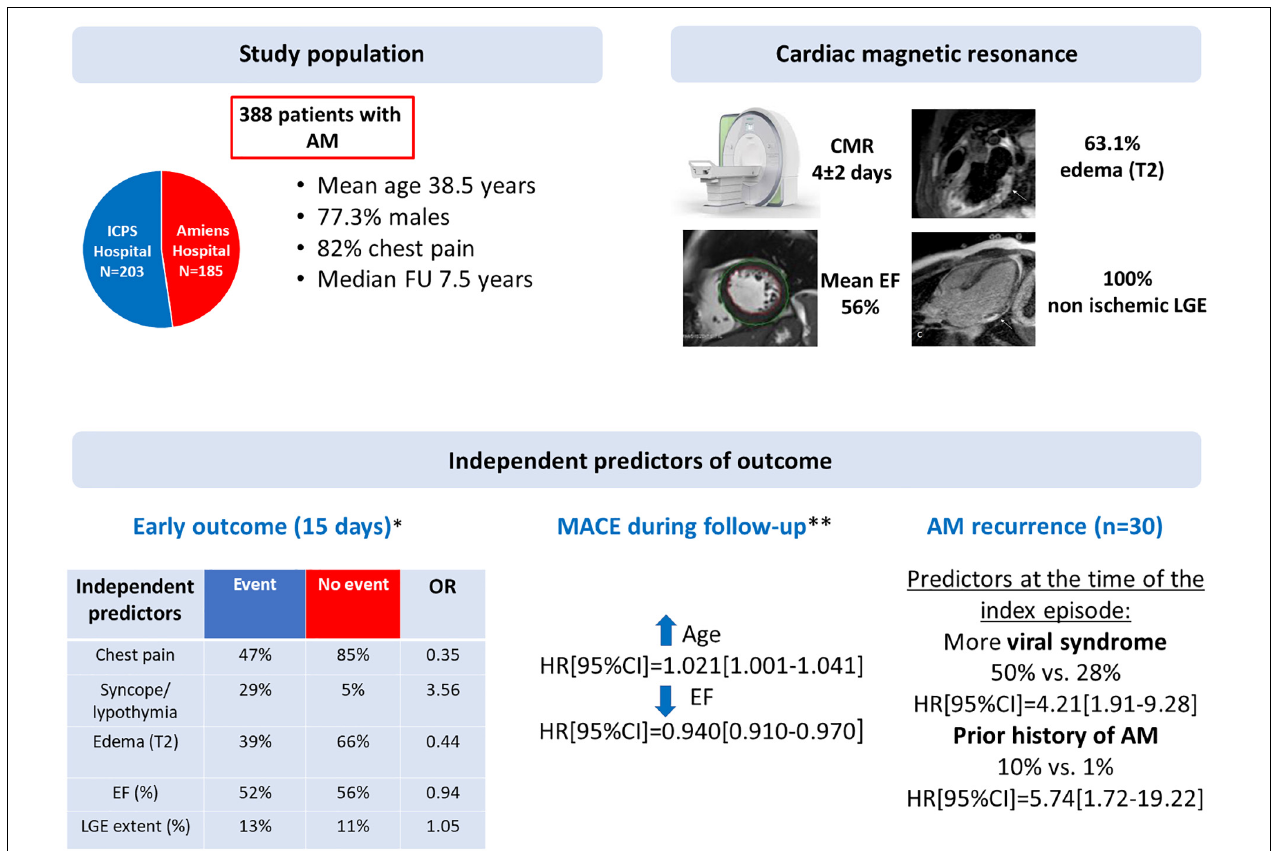
FIGURE 5 | Summary of the study: study population, CMR characteristics and independent predictors of outcome. AM, acute myocarditis; AV, atrioventricular; CI, confidence interval; CMR, cardiac magnetic resonance; EF, ejection fraction; HR, hazard ratio; LGE, late gadolinium enhancement; MACE, major cardiac events; OR, odd ratio. *Cardiac death, heart failure, ventricular arrhythmia or complete AV block ( n = 38). **Cardiac death, cardiac transplantation, sustained ventricular tachycardia hospitalization for heart failure or for cardiac causes ( n =